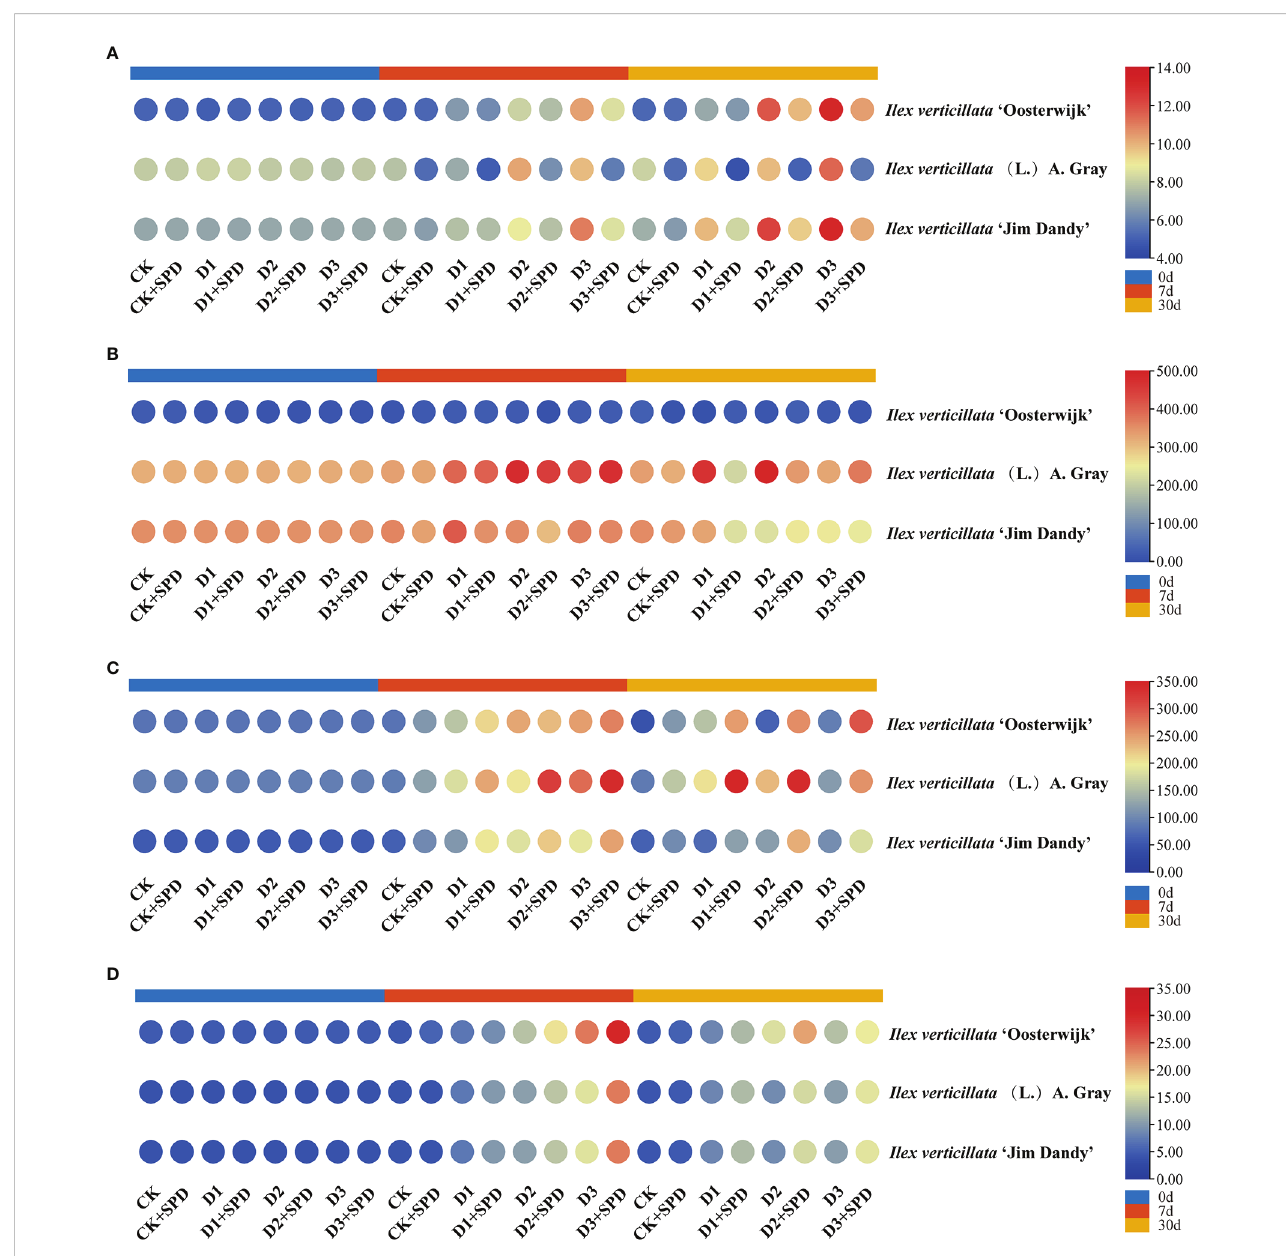
FIGURE 5 The changes in malonaldehyde content and antioxidant enzymes in Ilex verticillata leaves under drought and spermidine treatment. (A) MDA; (B) SOD; (C) POD; (D) CAT. Data were shown in different heatmaps, where red indicates high values and blue indicates low values. CK, control; CK+SPD, control with spermidine; D1, mild drought; D1+SPD, mild drought with spermidine; D2, moderate drought; D2+SPD, moderate drought with spermidine; D3, severe drought; D3+SPD, severe drought with spermidine. CAT, catalase; MDA, malondialdehyde; POD, peroxidase; SOD, superoxide